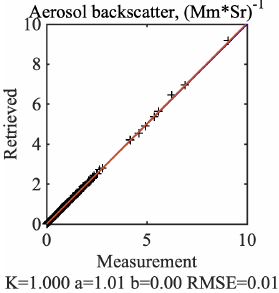
Figure 29. Achieved vertical profile backscatter fits at 455 and 940nm for data acquired on 5, 11 August 2015 and 12 August